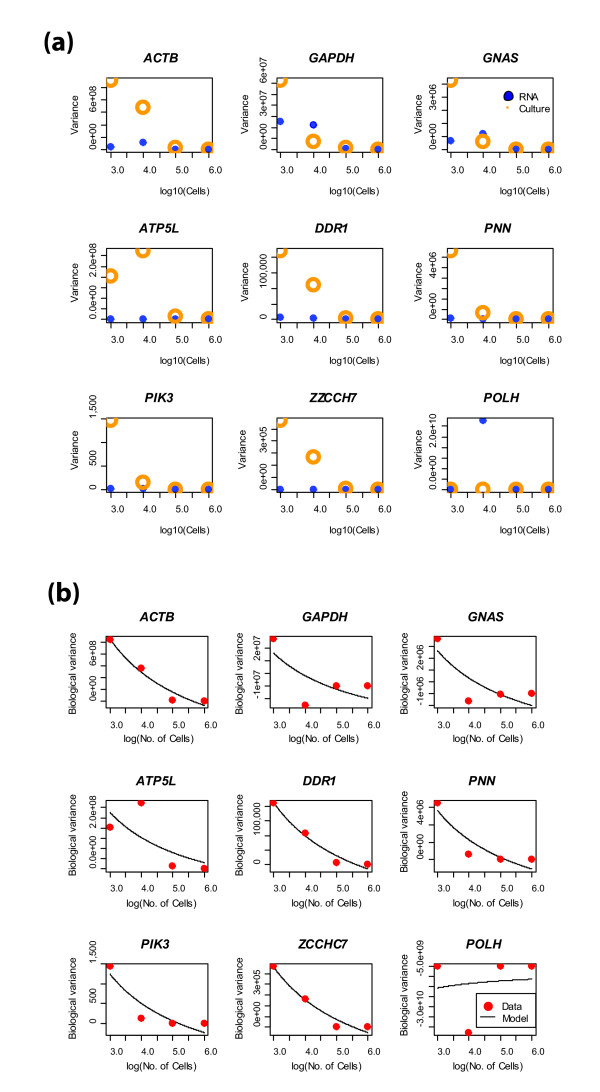
(a) Variances calculated from the experimental data for each step of the serial dilution series; variances from the RNA dilution are represented by solid blue circles, variances from the cell culture dilution are represented by the open orange circles. (b) Estimates of biological variability obtained from the validation experiment using quant values are shown by red dots; the trend predicted by our analytical model is shown by the bold black line. Data are displayed for nine genes targeted in our validation experiment.